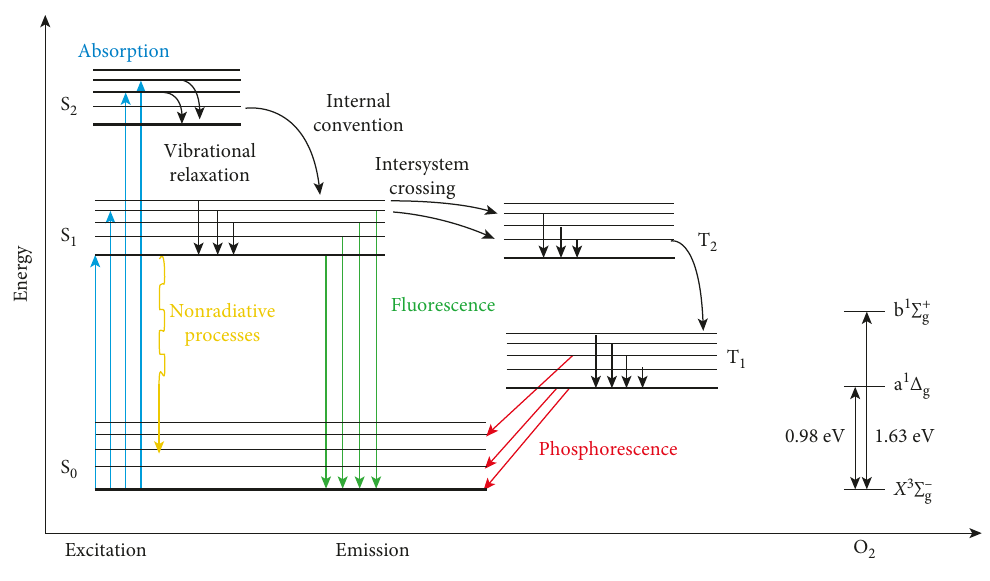
Figure 3: A Jablonski diagram and the electronic states of the oxygen